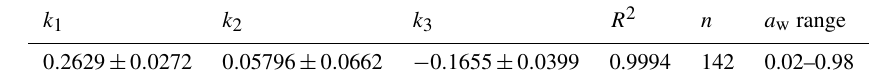
Table 2. Parameters characterizing the hygroscopic properties of glucose aerosol particles: best-fit values ( ± standard errors) for the three- parameter fit ( k 1 , k 2 , k 3 ; Eq. 17); n and R 2 are the number of data points and the coefficient of determination of the fit, respectively.